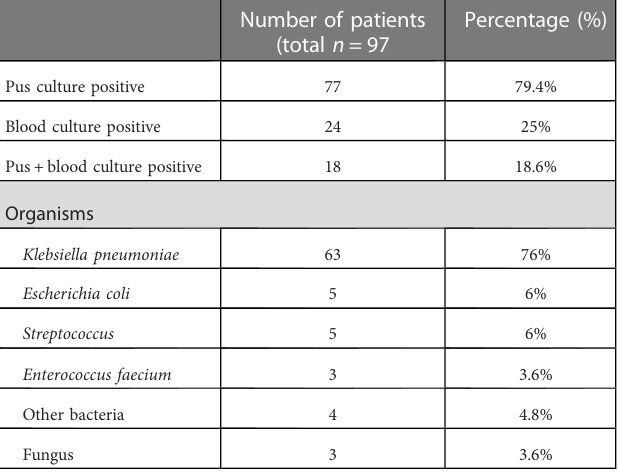
TABLE 5 Risk factors for septic shock — univariate and multivariate